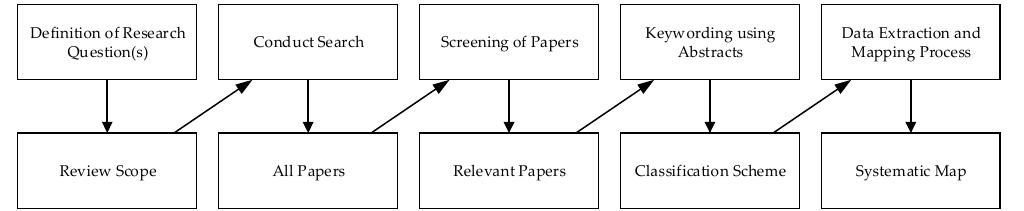
Figure 2. Systematic mapping study process adapted from [127].